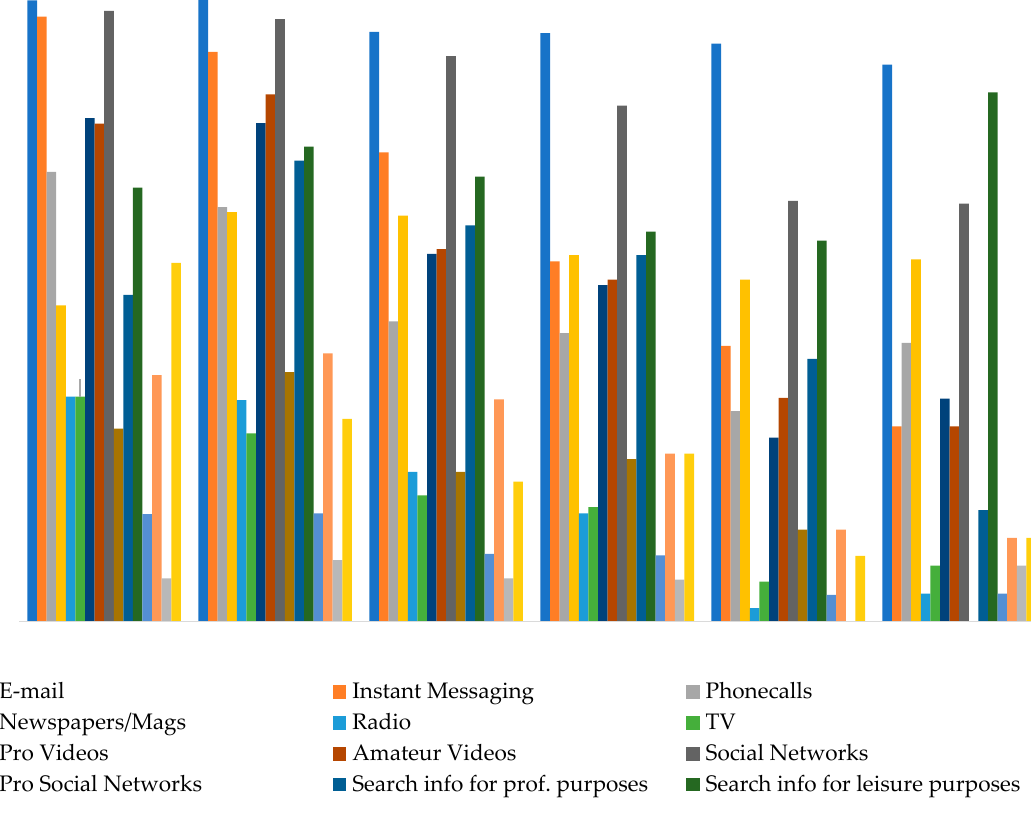
Figure 5. Activities carried out online by generation. Source: ERC2015—The new dynamics of audio-visual consumption in Portugal; n = 616.